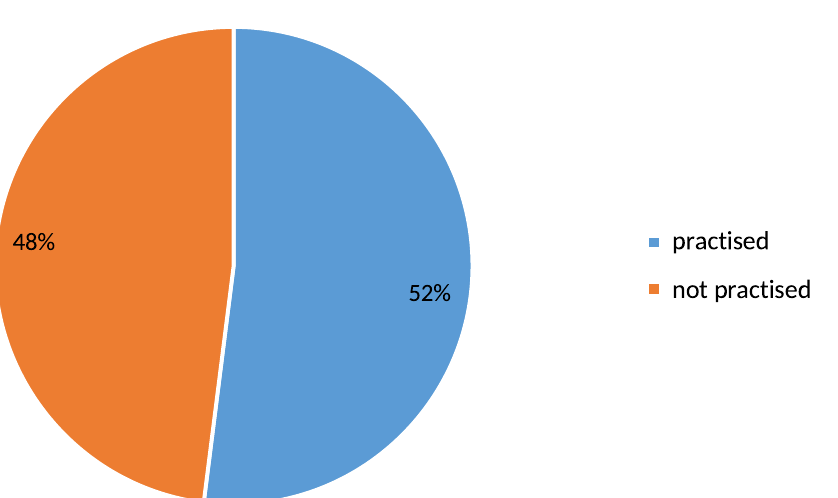
Figure 1. Prevalence of exclusive breast feeding practice among infants aged 6 months to 12 months in Chereti district, Somali region, southwestern Ethiopia, 2019, (n =